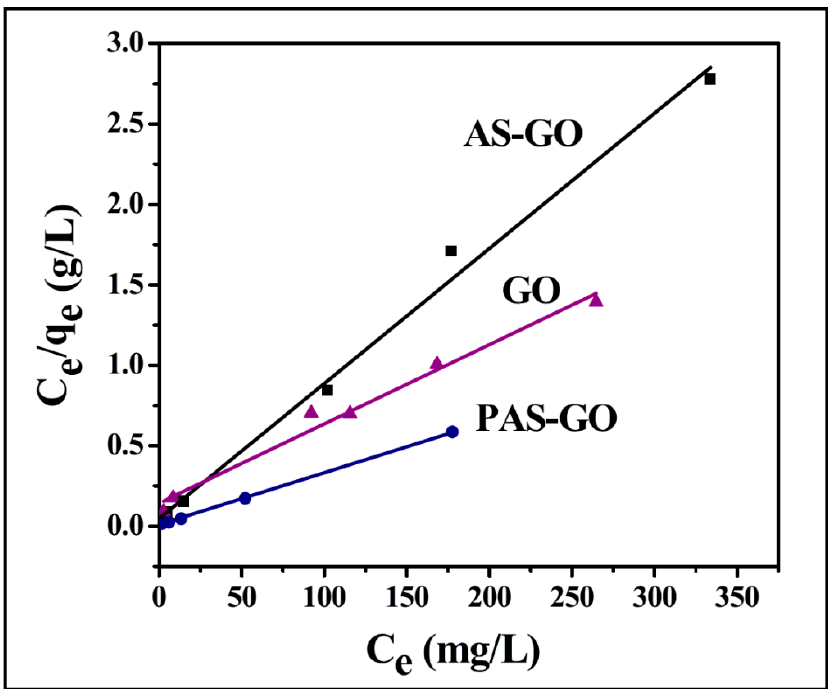
Figure 3. PAS-GO, AS-GO, and GO Langmuir isotherms for Pb(II) adsorption in aqueous solution at 303 K [193] . 389